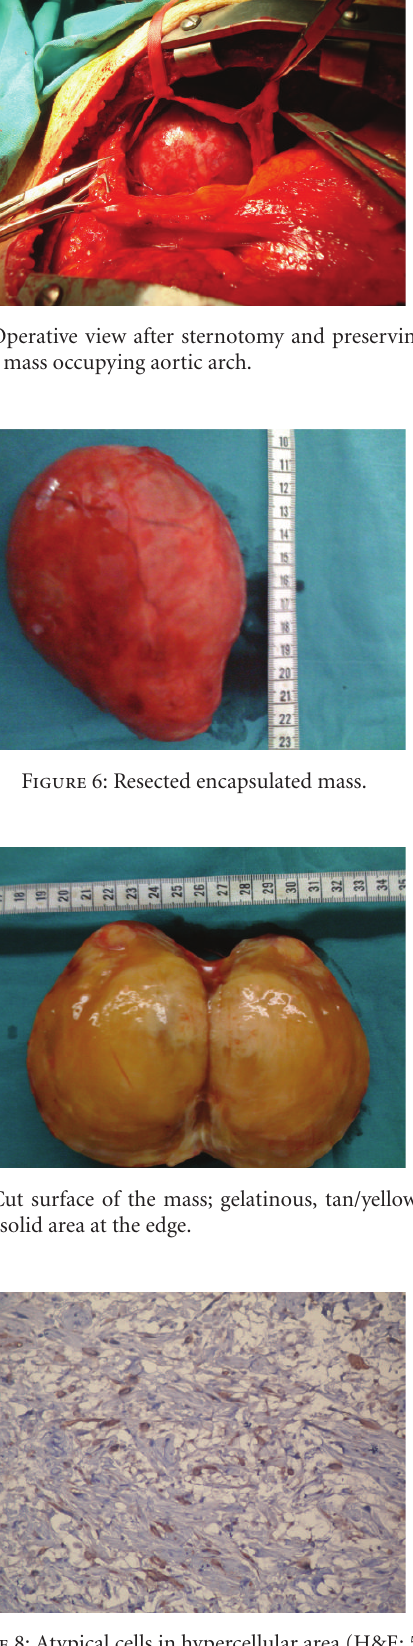
Figure 8: Atypical cells in hypercellular area (H&E; 50).